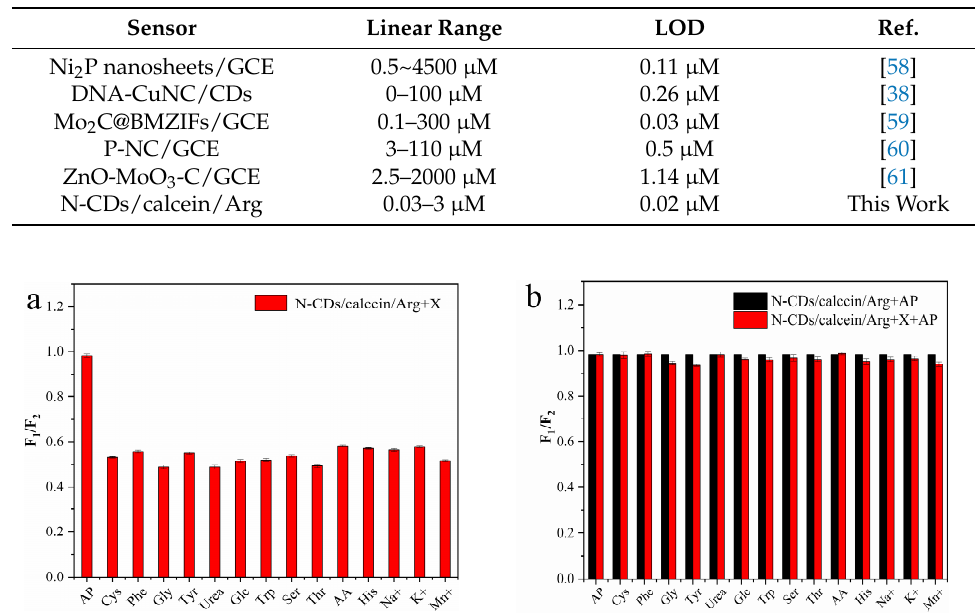
Figure 13. ( a ) Fluorescence intensity emission spectra of N-CD/calcein/Arg complex system with AP addition. Insets show fluorescence color change of N-CD/calcein/Arg complex system in ab- sence (left) and presence (right) of the addition of 3 μ M AP. ( b ) Fitting curve between F 1 /F 2 and C AP . Insets show fluorescence color change of N-CD/calcein/Arg complex system with increased C AP (from left to right). Table 2. Comparison of different sensors for AP sensing.